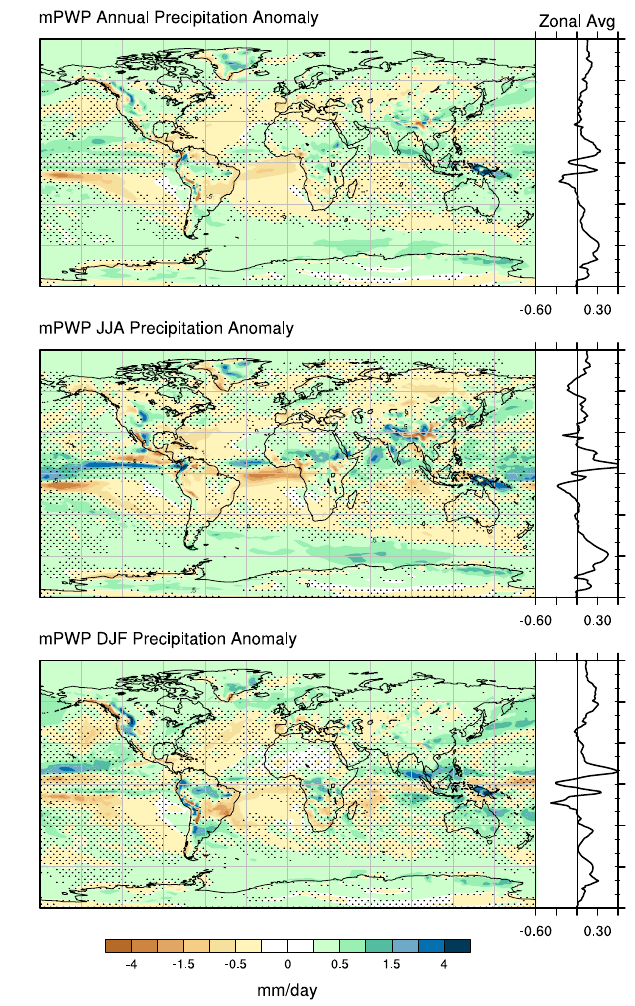
Fig. 4. CCSM4 simulated annual and seasonal mPWP precipitation change (mmday − 1 ) from PI control; stippling indicates results are not statistically significant at 95% level. Zonally averaged precipi- tation change (mPWP minus control) is plotted in the side